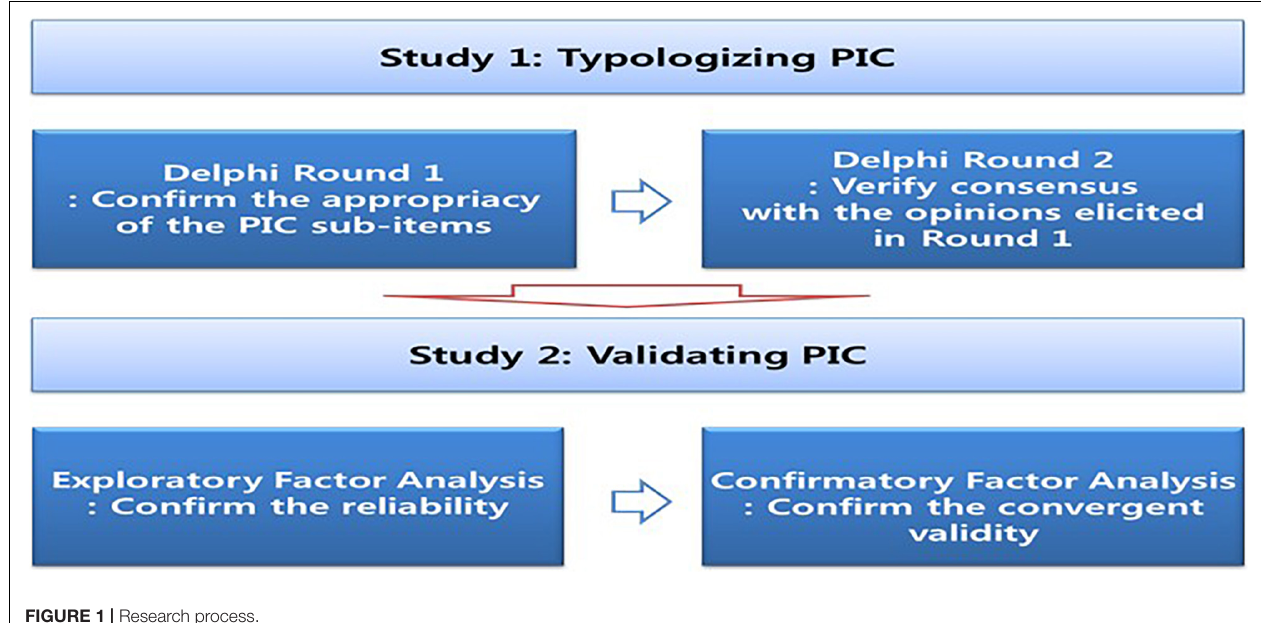
FIGURE 1 | Research process. TABLE 1 | Characteristics of the Delphi